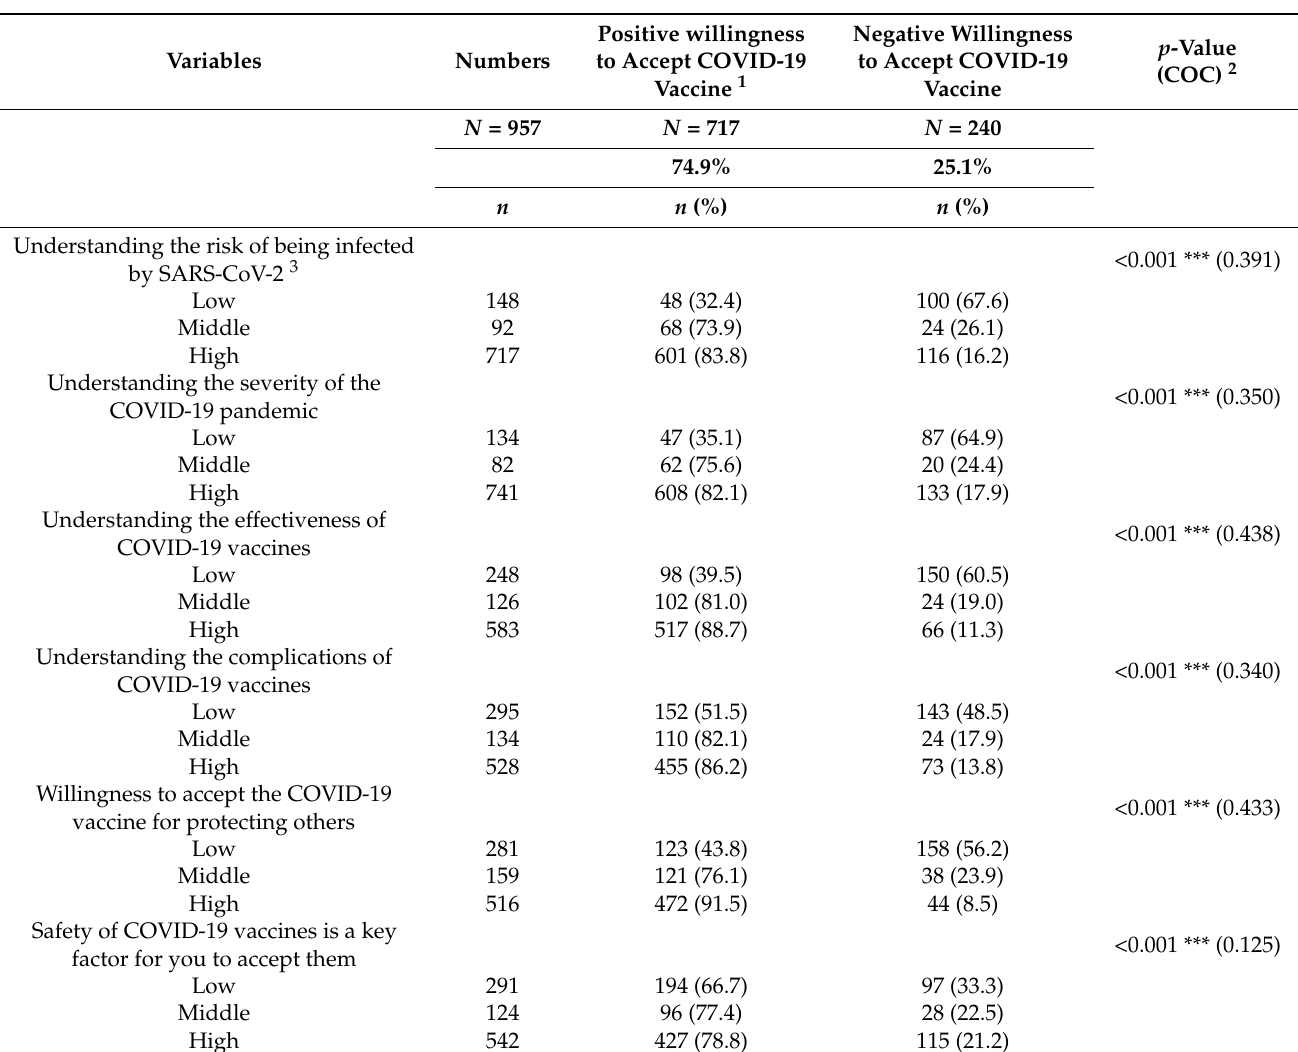
Table 2. Awareness of the COVID-19 pandemic and attitudes toward receiving the COVID-19